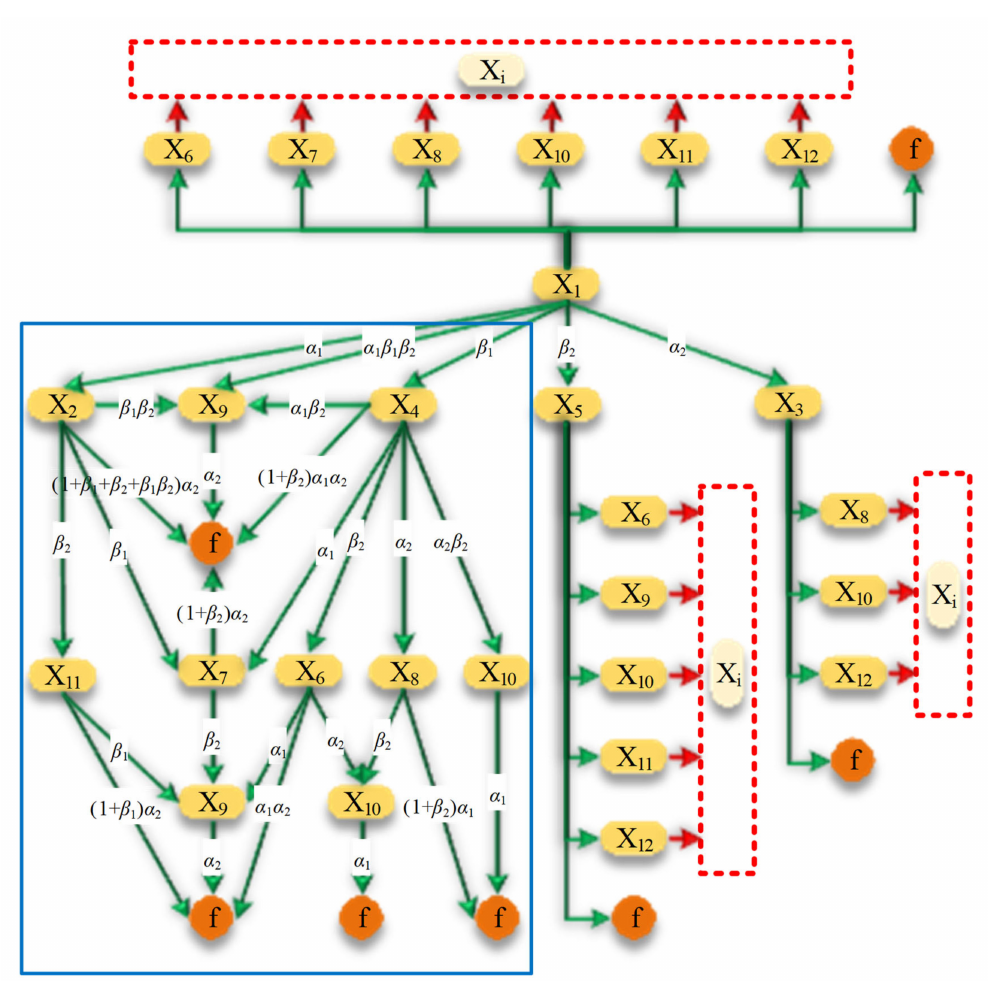
Figure 9. State transition of the Markov